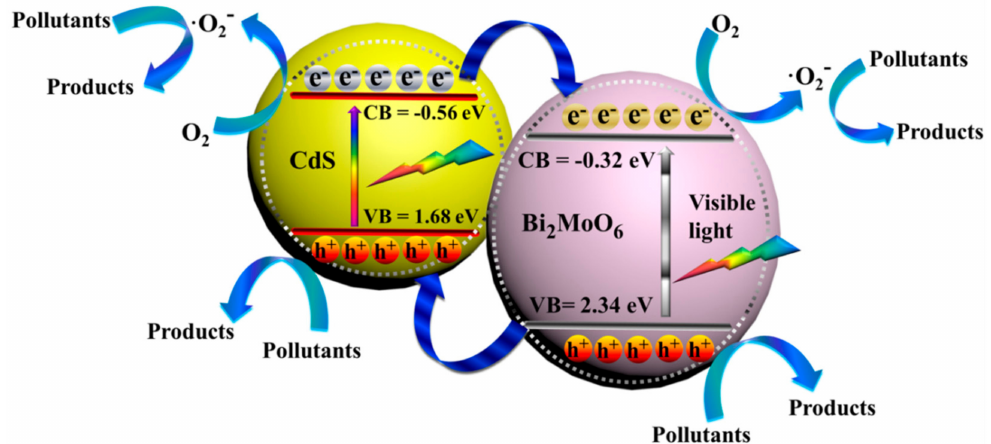
Figure 8. Photocatalytic mechanism scheme over CdS/Bi 2 MoO 6